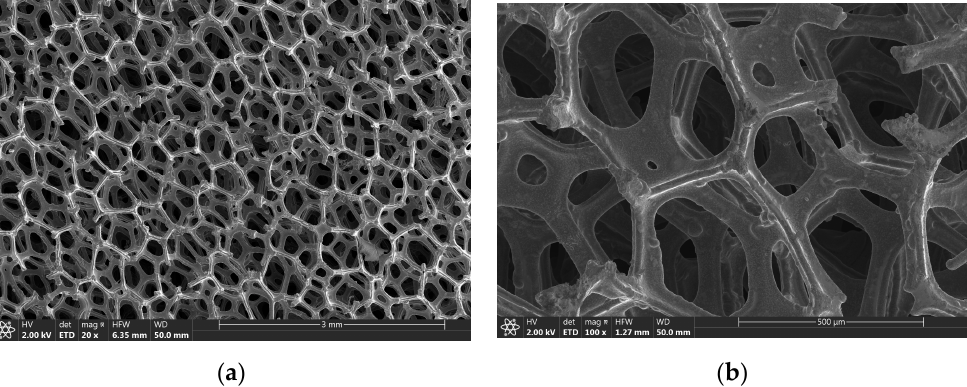
Figure 1. Structural morphologies of the porous metal obtained by the scanning electron microscope ( a ) with a low magnification of 20× and ( b ) with a high magnification of 100×.